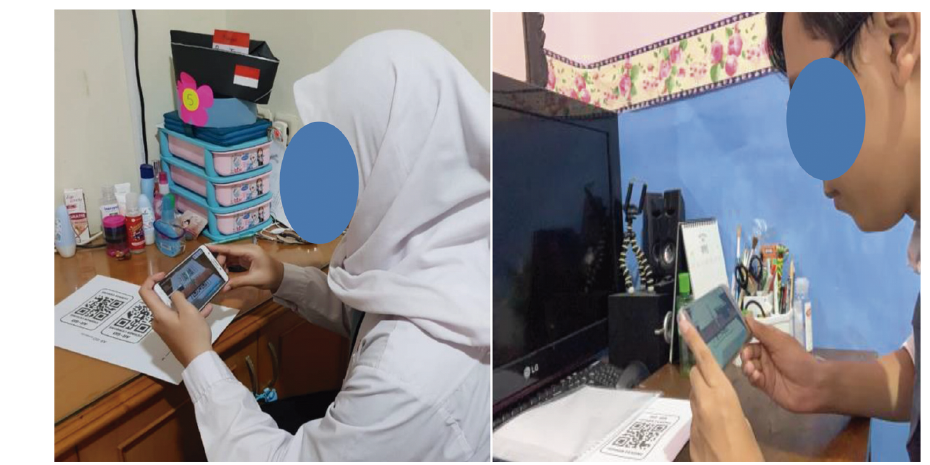
Figure 7. Students of ARI